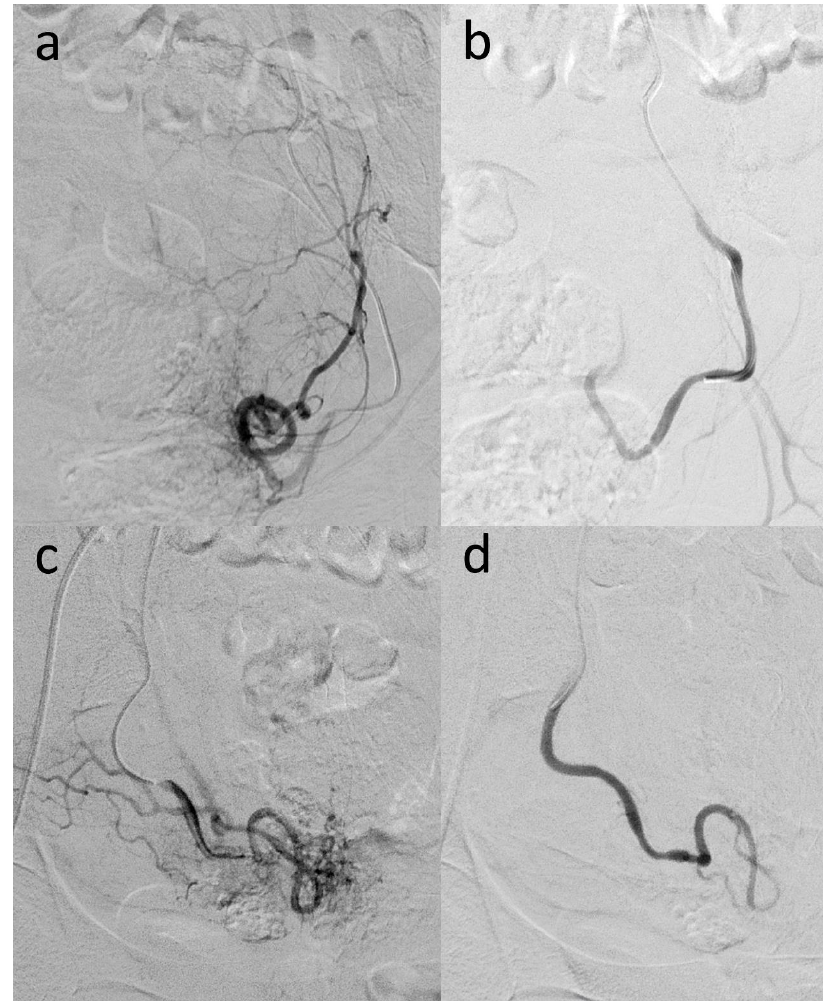
Figure 2. The UAE procedure was initiated with an ultrasonography-controlled transfemoral retro- grade approach under local anesthesia. The left internal artery was catheterized with the cross-over technique. After selective angiography, the left uterine artery was visualized ( a ), catheterized, and selectively embolized with Embozene Microspheres™ (400 μm particle size) (Boston Scientific, Marlborough, USA) until the stagnation of blood flow occurred ( b ). Subsequently, the right internal iliac artery and, super selectively, the right uterine artery were catheterized. After selective visuali- zation of the hyper vascularized uterine zone ( c ), it was embolized with Embozene Microspheres (250–400 μm particle size) (Boston Scientific, Marlborough, MA, USA) until the stasis of blood flow was attained ( d ). Angiographic control was performed, and no flow was seen in either of the uterine arteries. No other vascularization was affected. The patient was returned immediately after the pro- cedure to the gynecologic department.